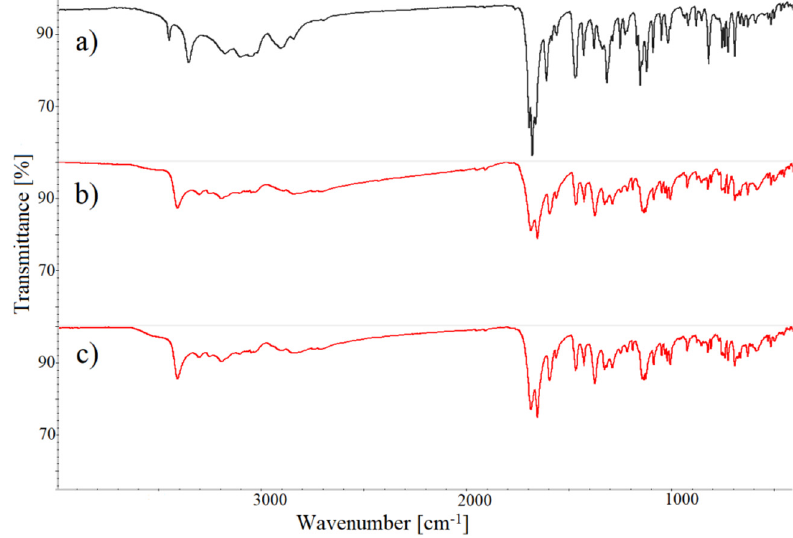
Figure 9. FTIR spectra of: ( a ) lorazepam physical mixture with nicotinamide, ( b ) lorazepam co-crystals with nicotinamide prepared by slurry evaporation method and ethyl acetate as a solvent, and ( c ) lorazepam co-crystals with nicotinamide prepared by liquid-assisted grinding method with methanol as a solvent.